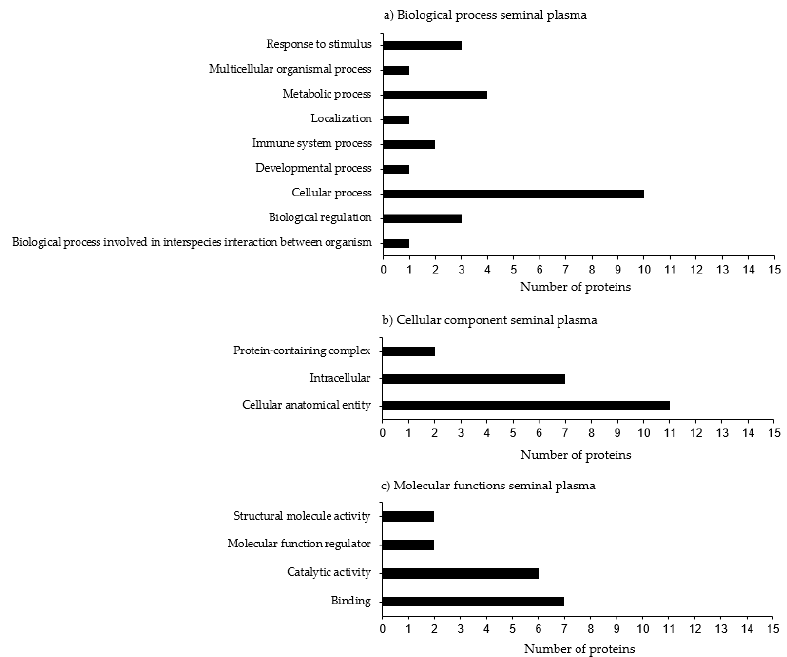
Figure 2. Gene Ontology terms of Bali bull seminal plasma protein based on ( a ) biological process, ( b ) cellular component, and ( c ) molecular function seminal plasma.